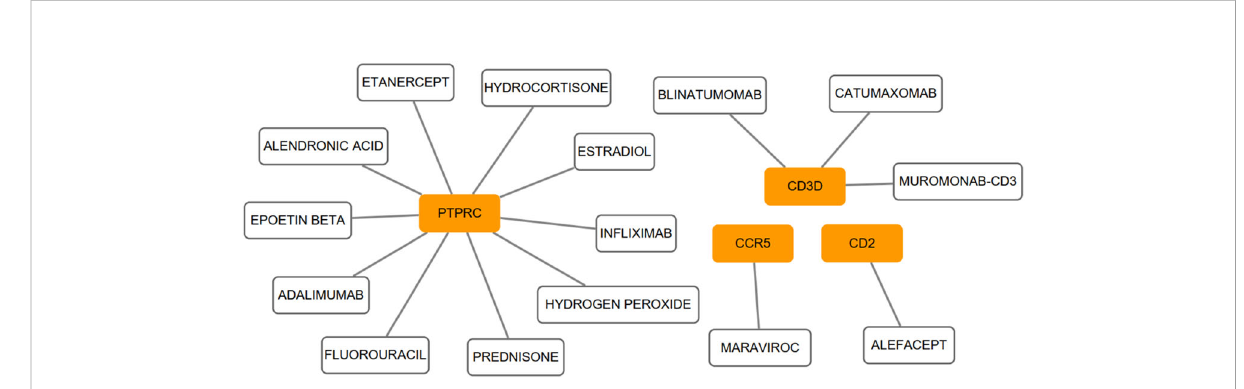
FIGURE 7 On the ground of the DGIdb database, the drug-gene pairs network was generated via Cytoscape, consisting of 4 hub genes (PTPRC, CD3D, CCR5 and CD2) and 15 drugs. Yellow circle indicates the hub gene and blank square indicates the